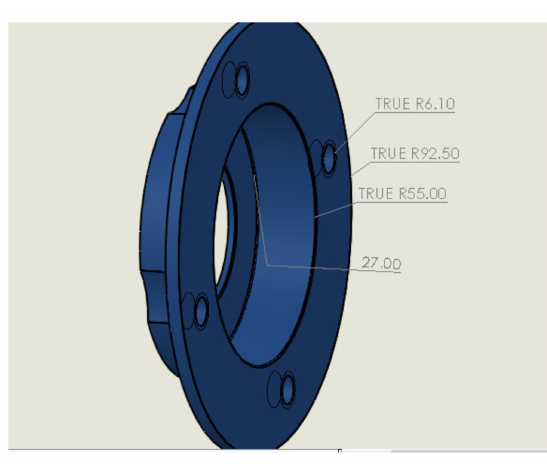
Figure A2. Bearing housing (Dimensions in mm).